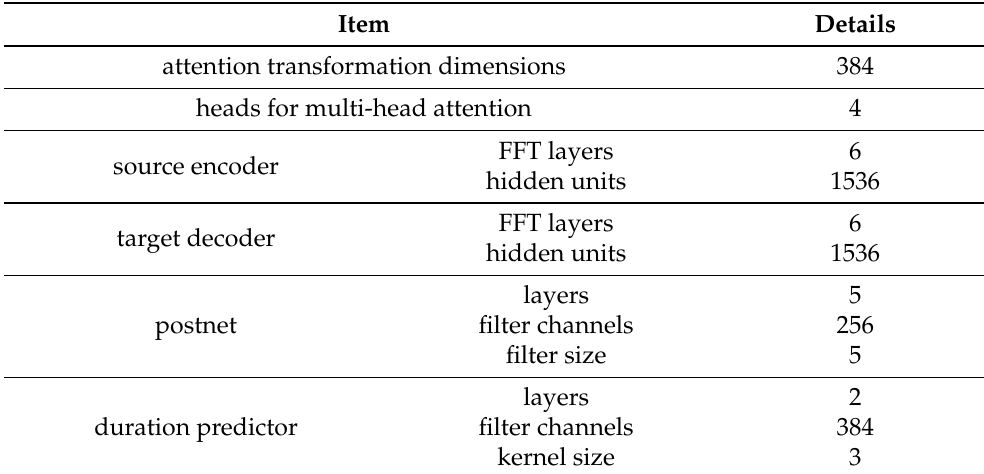
Table 3. Hyper-parameters of SSRNet.